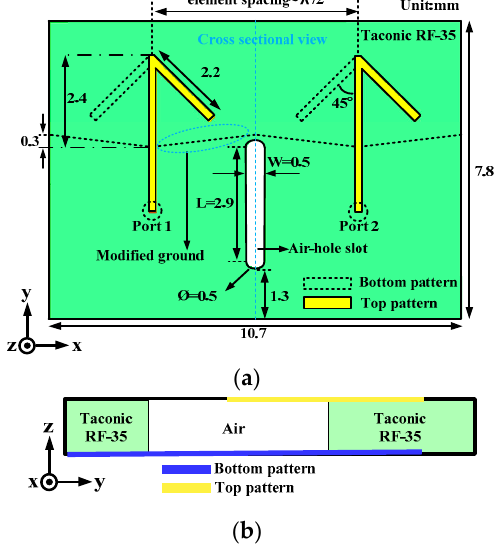
Figure 2. Structure of the proposed two-element array antenna: ( a ) top view ( b ) cross-sectional view.